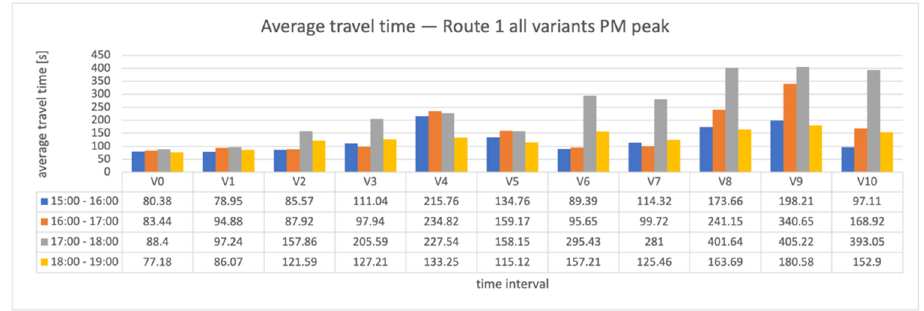
Figure 8. Average travel time; Section 1—all variants—PM peak.